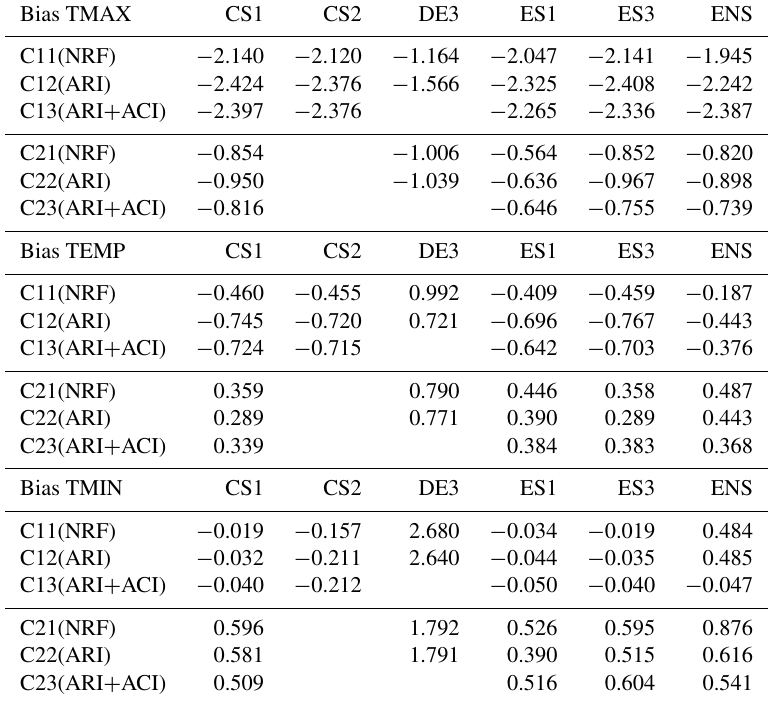
Table 2. Domain-averaged bias (in K) for the fire (C1X) and dust (C2X) episodes of each simulation with respect to the E-OBS database.